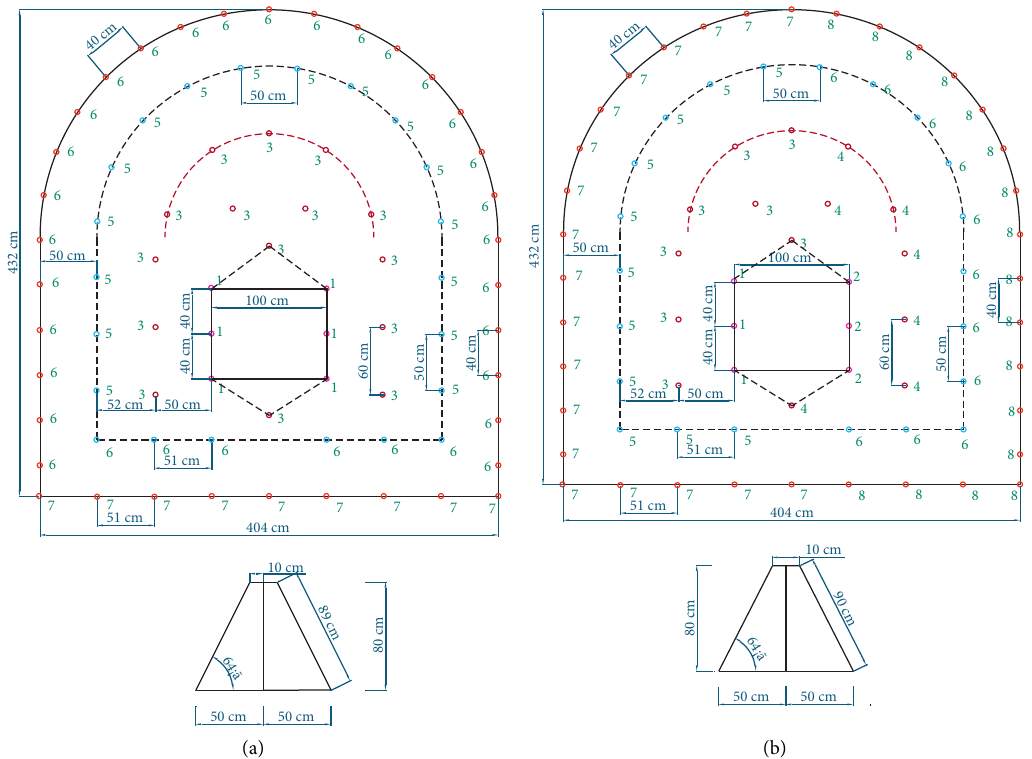
Figure 7: The blasting hole layout: (a) conventional blasting holes and (b) phase-difference shock absorption blasting